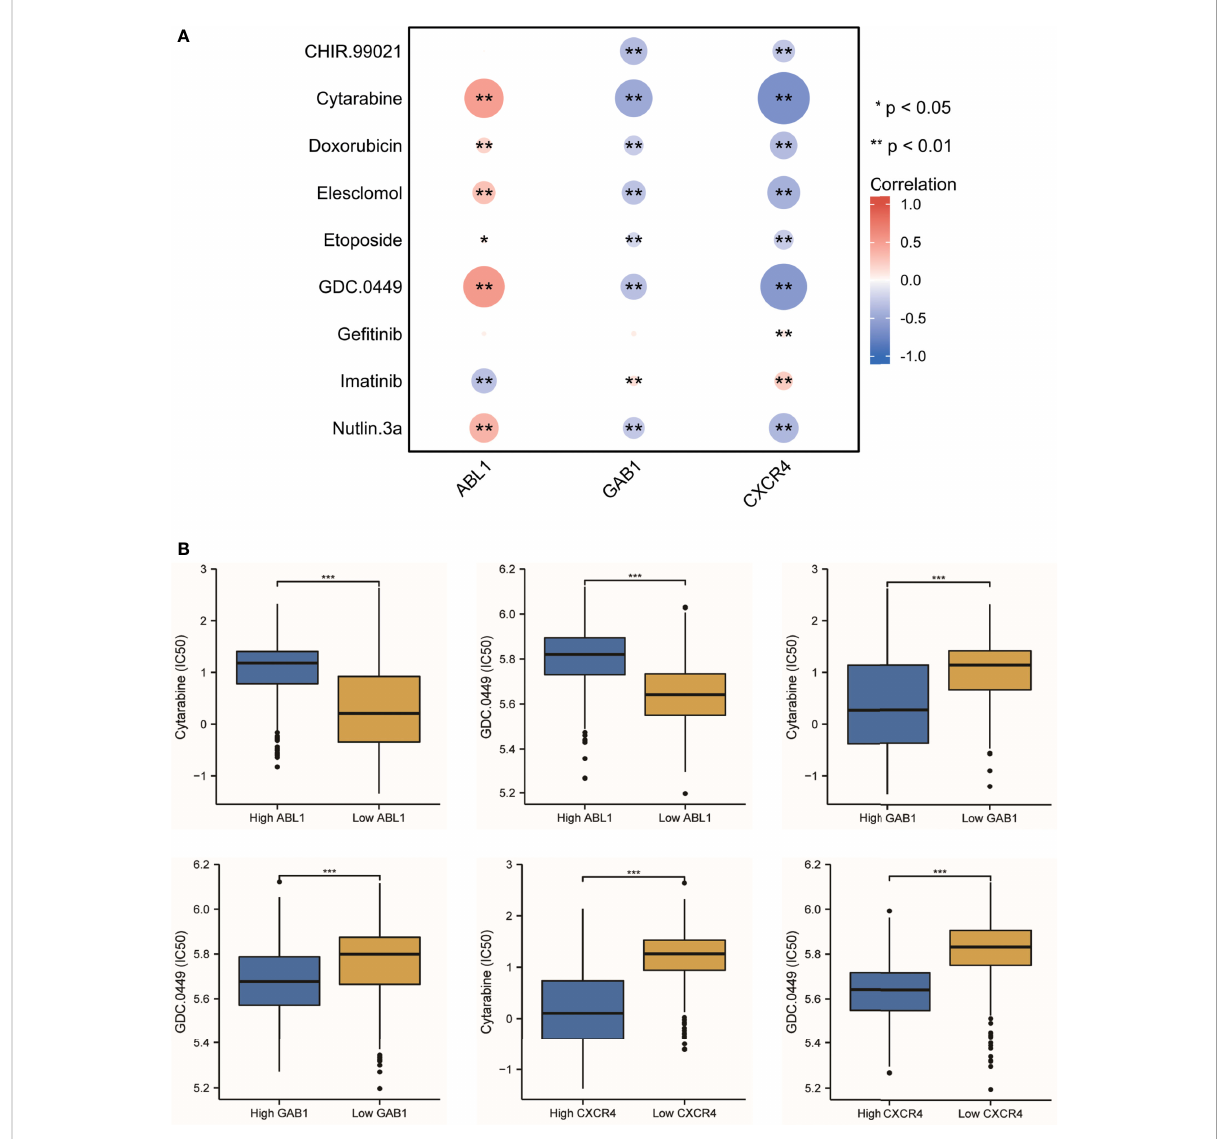
FIGURE 9 The antitumor drug sensitivity correlated with the immune hub genes. (A) Nine antitumor drug sensitivities are correlated with the immune hub genes (* p < 0.05, ** p < 0.001). (B) The IC50 of cytarabine and GDC.0449 showed the difference between the high-expression hub gene group and the low-expression hub gene group (*** p ≤